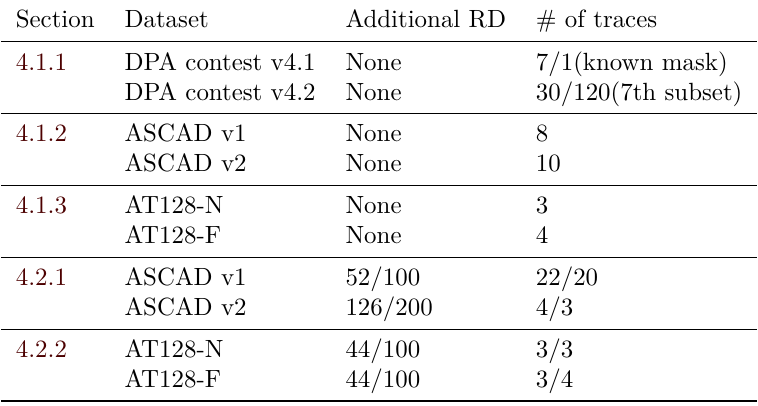
Table 1: Summary of